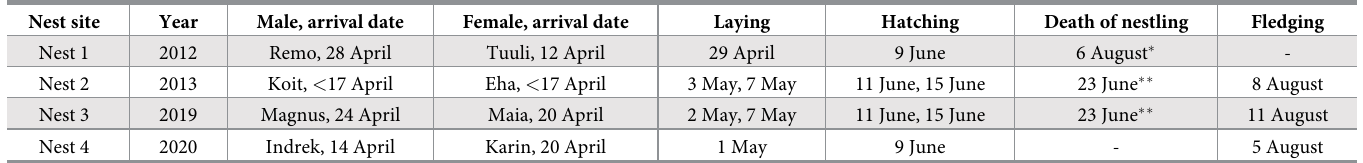
Table 1. Main breeding events recorded at four nests of the Lesser Spotted